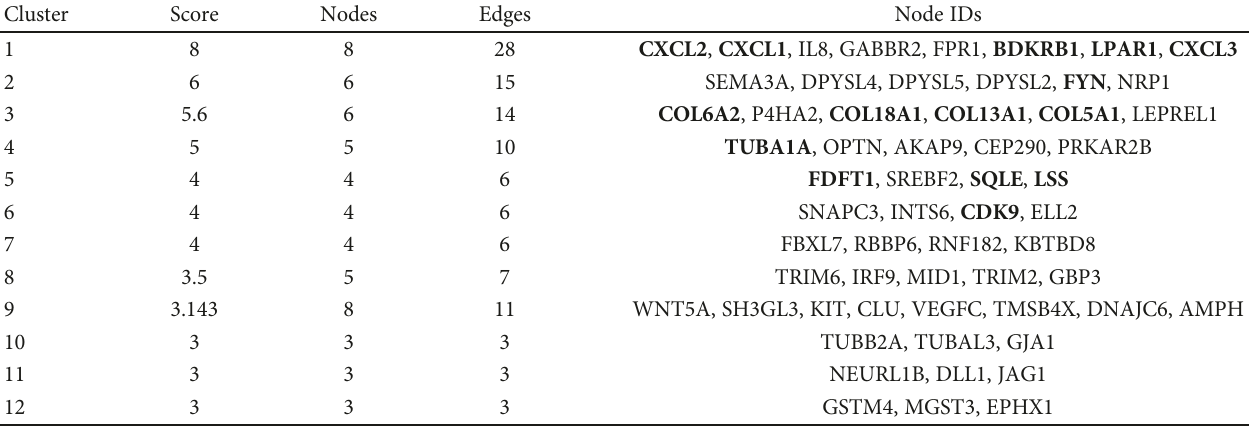
Table 5: Twelve module networks analyzed by MCODE.